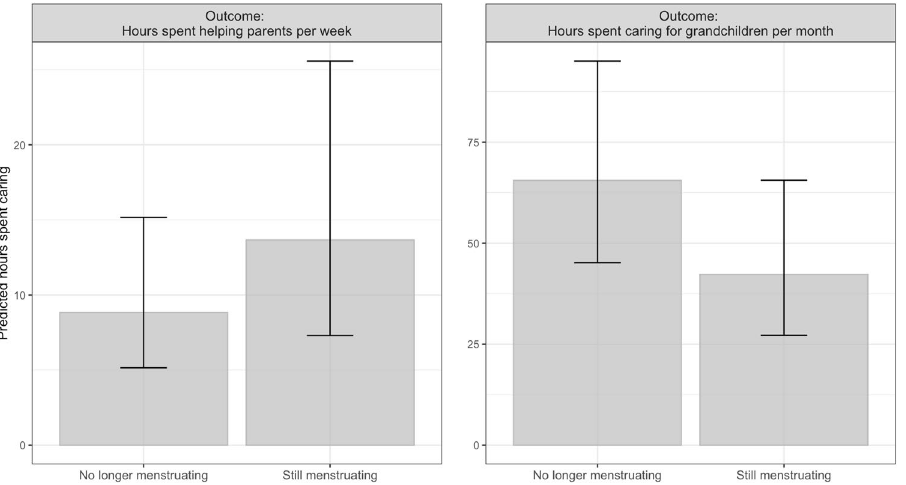
Figure 2. Predicted number of hours spent helping parents and caring for grandchildren relative to fecundity status, based on the results from negative binomial parts of the best fitting models. Error bars indicate the 95% confidence intervals. Models adjust for number of grandchildren, the age the woman left education, employment status, marital status, and health. Where hours spent helping parents is the outcome, time spent caring for grandchildren is also controlled for, and vice versa where hours spent caring for grandchildren is the